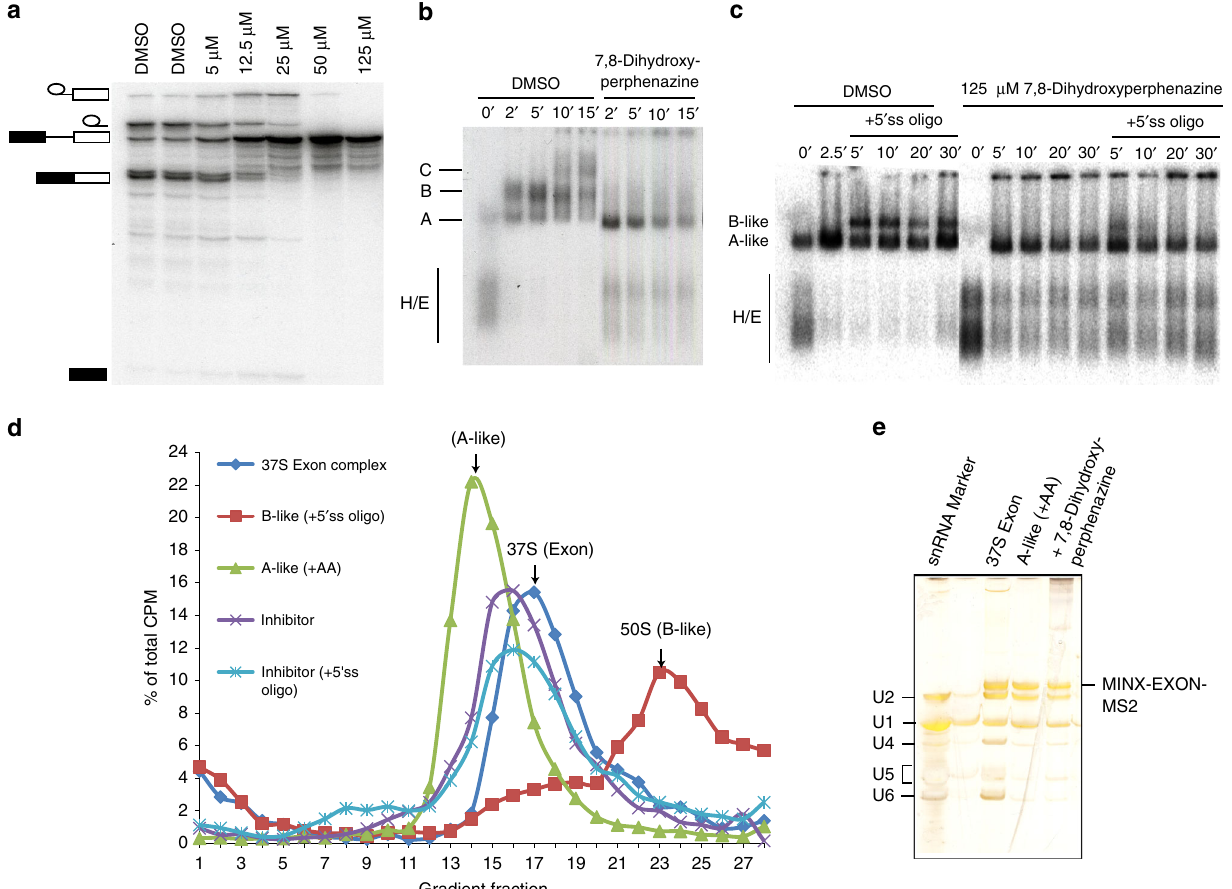
Fig. 6 The effects of 7,8-dihydroxyperphenazine on in vitro splicing and cross-exon complex formation. a 7,8-dihydroxyperphenazine completely inhibits MINX pre-mRNA splicing at 50 μ M and ( b ) inhibits spliceosome assembly after complex A formation. c – e 7,8-dihydroxyperphenazine does not affect cross-exon A-like formation but inhibits U4/U6. U5 tri-snRNP docking to the cross-exon A-like complex. Anacardic acid (AA), which disrupts the U4/U6.U5 tri-snRNP, was used as a positive control to stall assembly at the A-like complex stage. Pre-mRNA splicing inhibition experiments, and gradient centrifugation and af fi nity selection of the cross-exon complexes were performed in at least two independent experiments with similar results. The Uncropped gel images are included in the Source Data fi